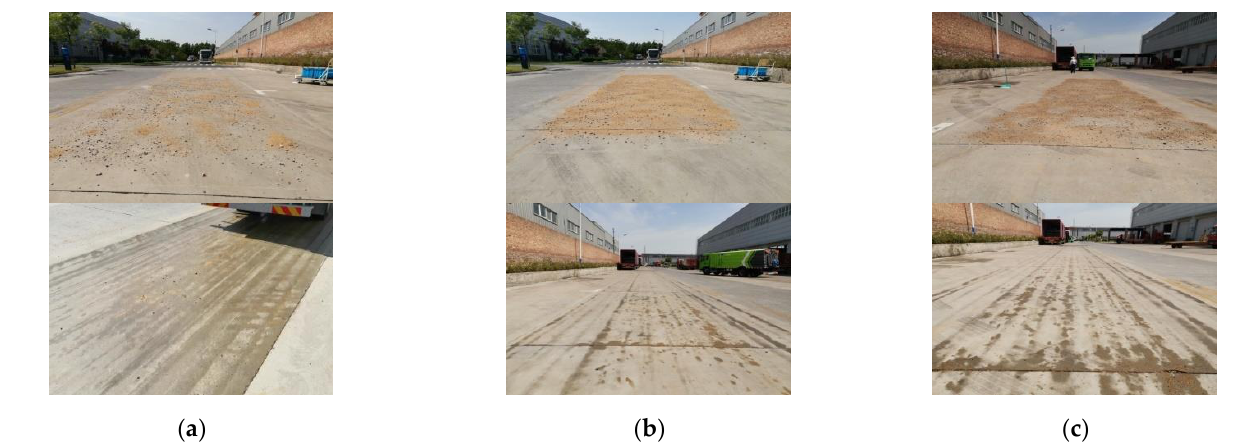
Figure 9. Field experiment results: ( a ) under general mode, ( b ) under standard mode, and ( c ) under extreme mode. Table 3. Experiment results.